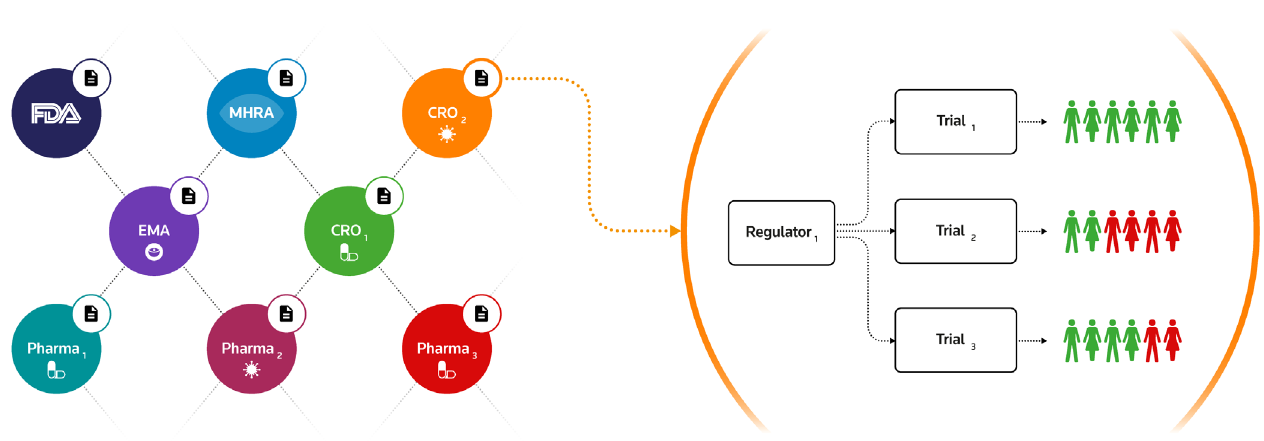
Figure 1. A private blockchain network consisting of regulators, pharma and contract research organisations. The system is composed of a hierarchical arrangement of two core types of smart contract - regulator contracts and trial contracts - with subjects and their associated clinical measurements appended to a container within the trial contract. The logic within the trial contract effectively enforces aspects of the trial protocol, ensuring that neither subjects nor measurements are appended outside of the predetermined trial timelines, while the tamper resistant characteristics of the blockchain prevent data